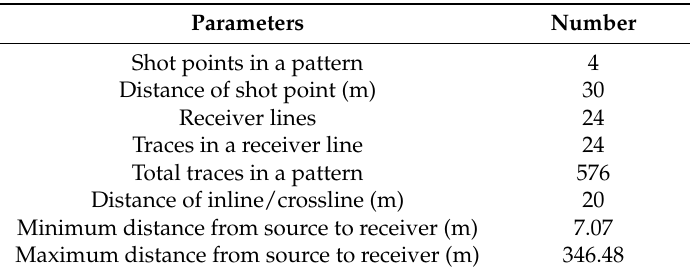
Table 2. Geometry of the seismic data acquisition.